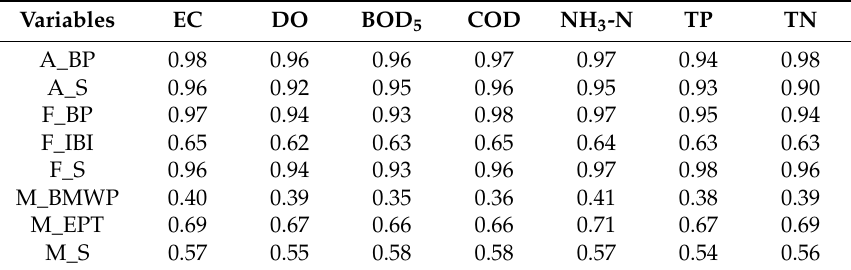
Table 4. Squared correlation coefficient (R 2 ) values for sensitivity analysis.